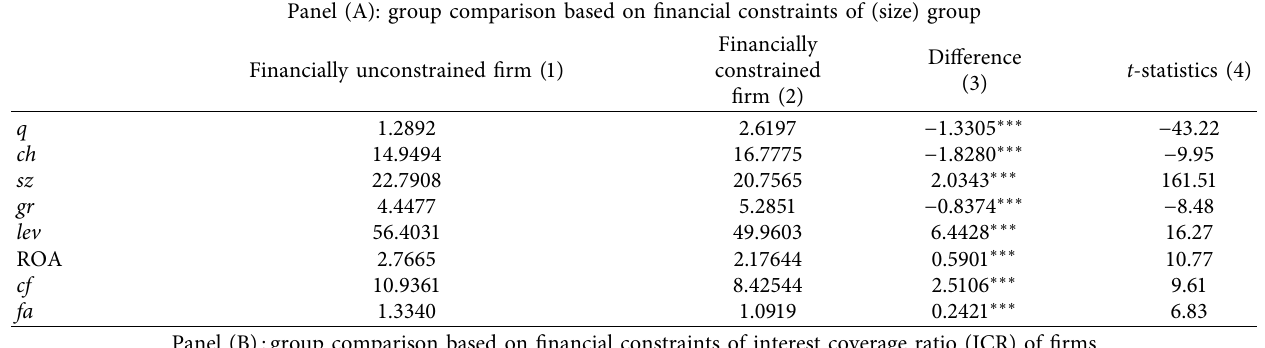
Table 6: Group comparison based on financial constraints. Panel (A): group comparison based on financial constraints of (size)